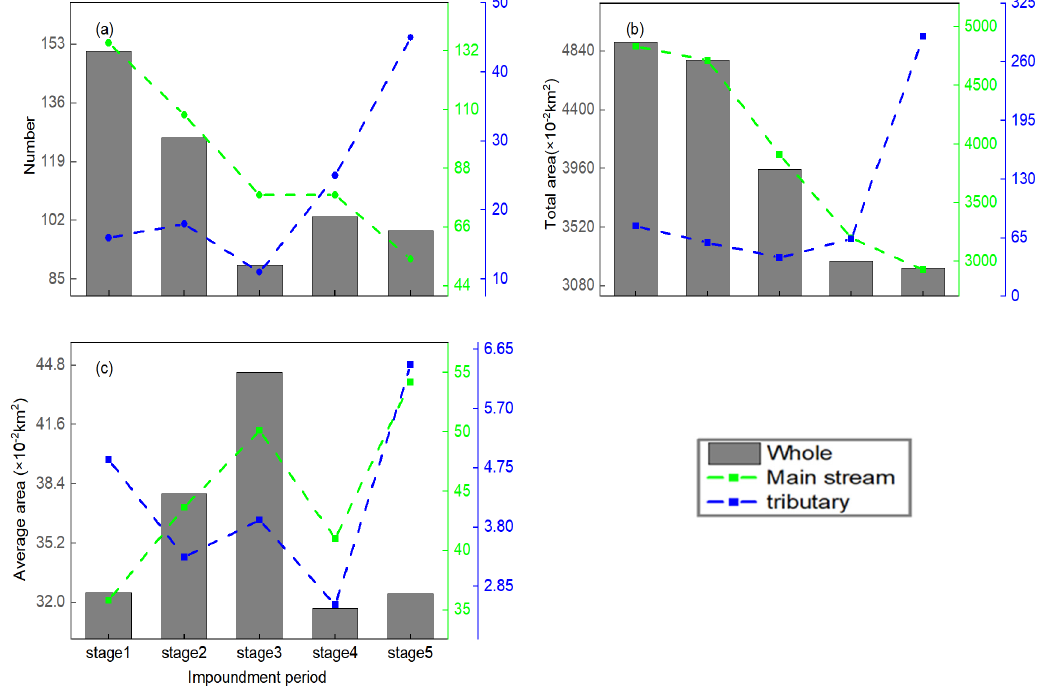
Figure 3. Number and area changes for MCBs during different impoundment periods: ( a ) number, ( b ) total area and ( c ) average area.